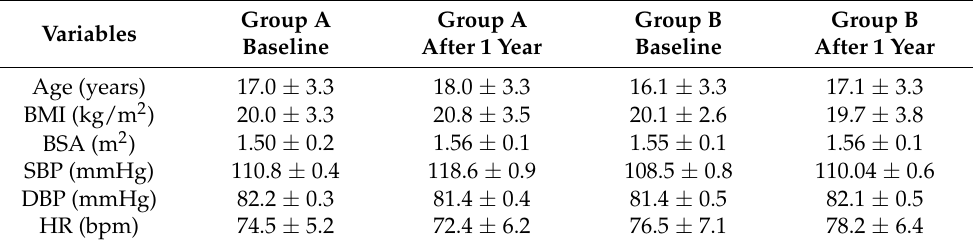
Figure 1. The CONSORT diagram of the study design. * reasons. The demographic and clinical characteristics of the 42 patients (21 in each group) at baseline and after one year are presented in Table 1. Table 1. The demographic and clinical characteristics of the study population at the baseline and after one year 1 .